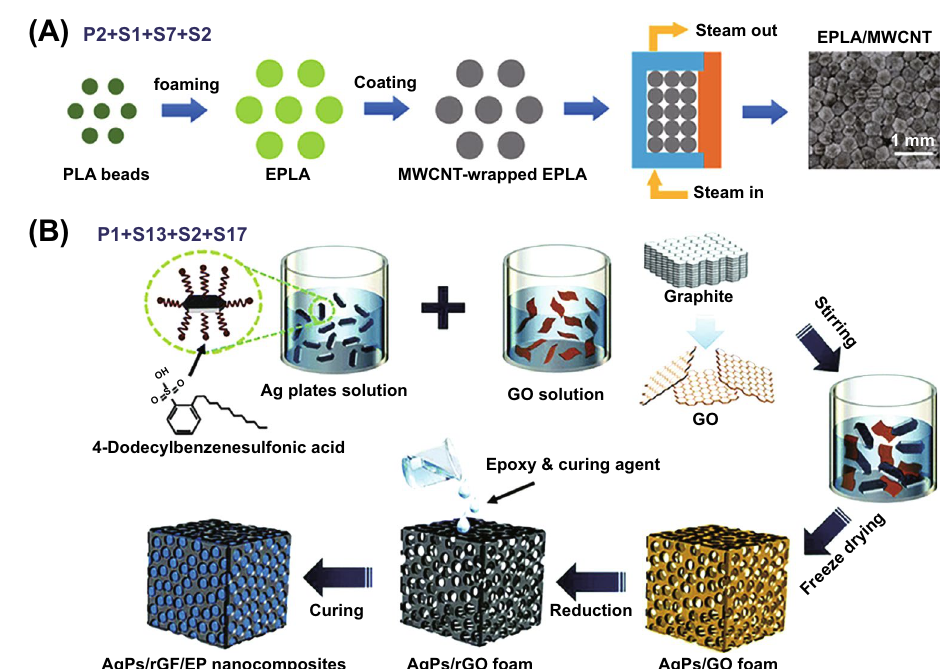
Fig. 12 A Schematic illustration of the fabrication process of polylactic acid (PLA)/MWCNT composite foam with segregated conductive CNTs network. Reprinted with permission from Ref. [177]. B Sketch of the fabrication of the AgPs/rGO foam/epoxy composite materials. Reprinted with permission from Ref.